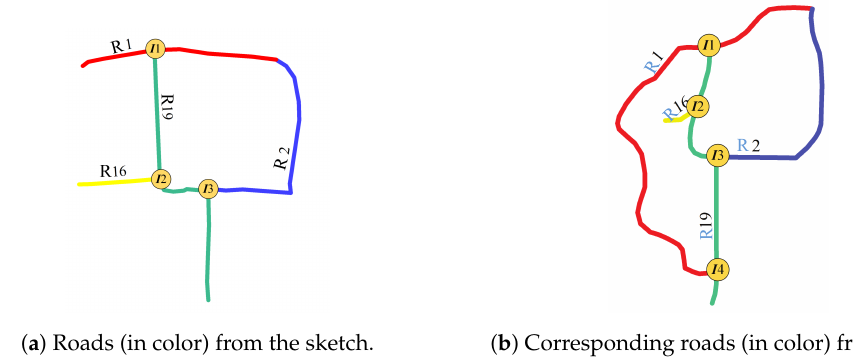
Figure 14. Roads R1, R2, and R16 (red, yellow, and blue lines, respectively) intersect with road R19 (green line) at I 1, I 2, I 3, and I 4,